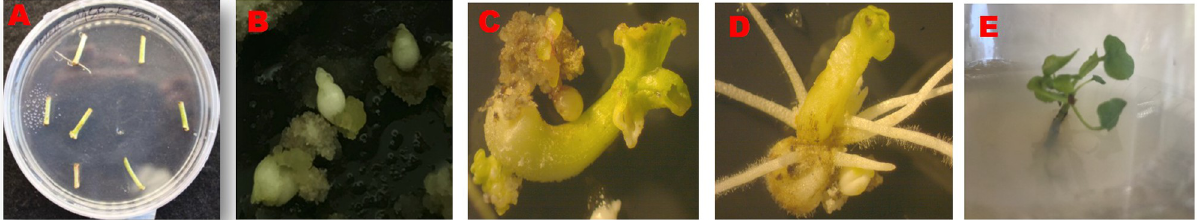
Fig 3. Cotton transformation stages. (A) Agro -transformed hypocotyls, (B) Embryos regenerated from callus, (C) Shoot development, (D) Root development, (E) In-Vitro plant.